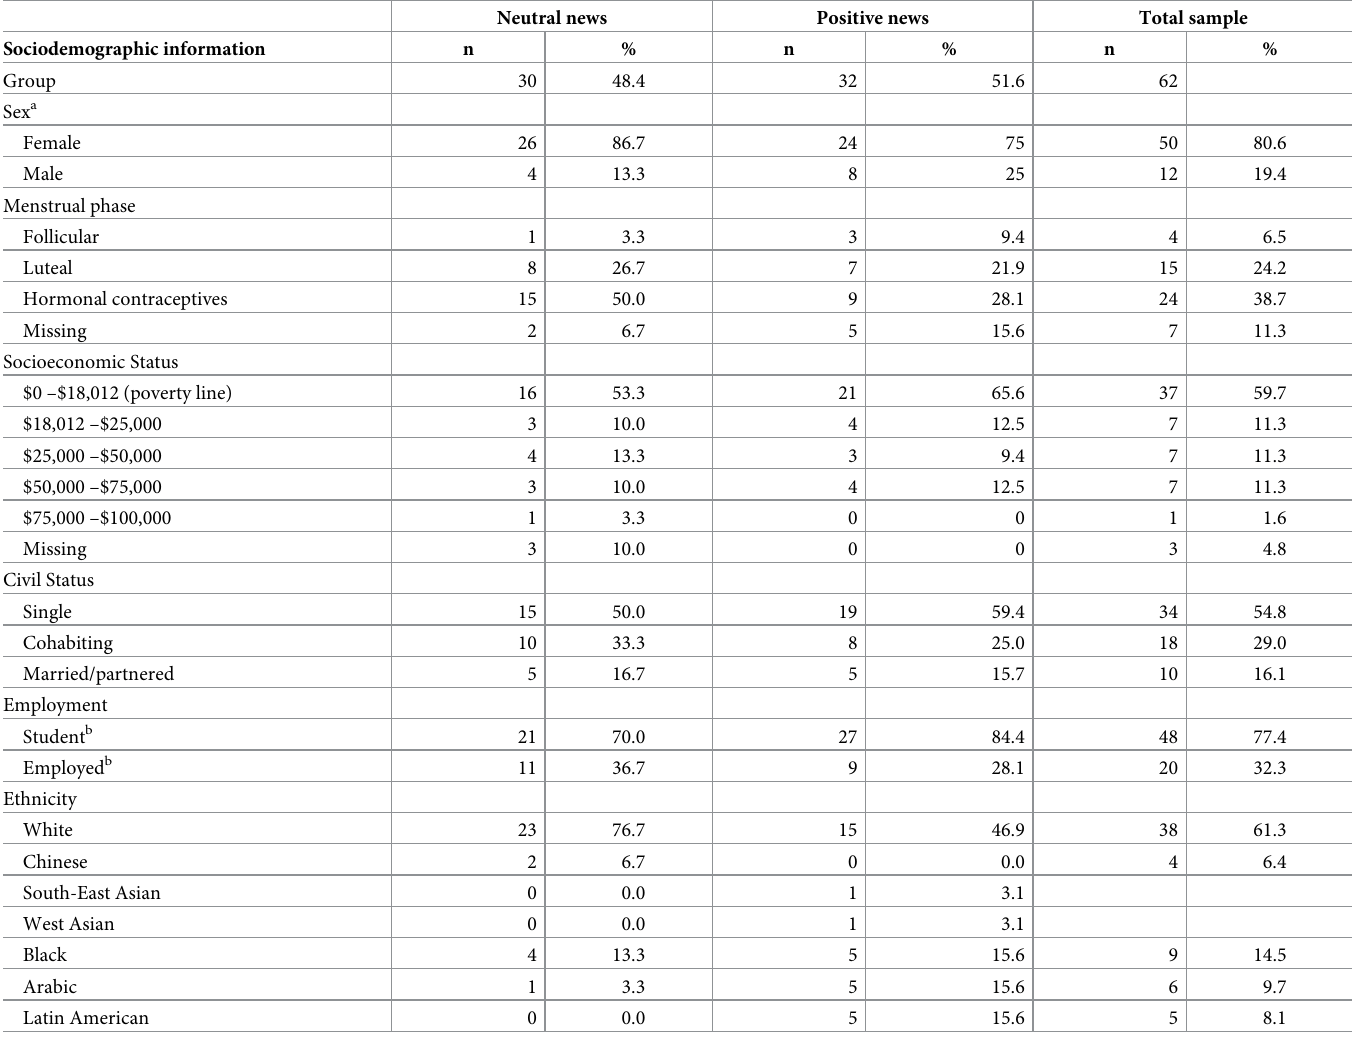
Table 2. Sociodemographic participant’s